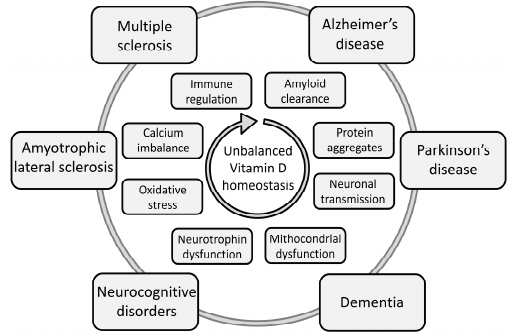
Figure 1. Schematic overview of neurological disorders and their underlying mechanisms relating to impaired homeostasis of the vitamin D system.